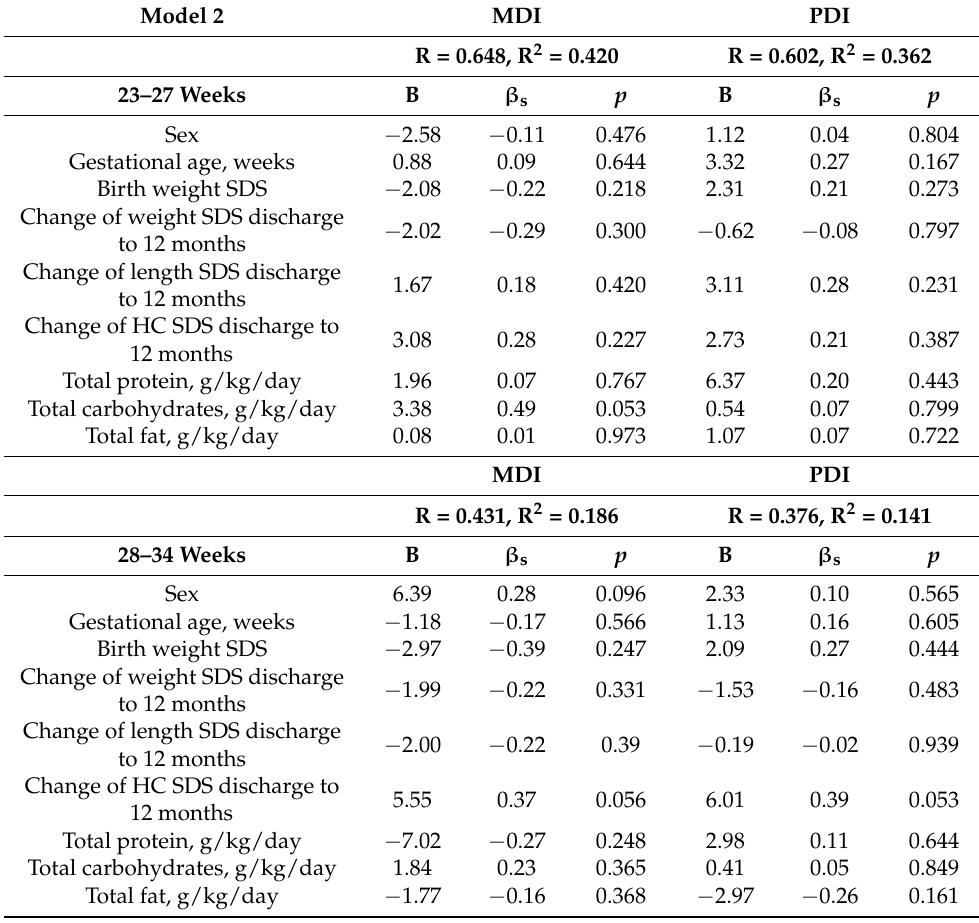
Table 5. Relationship between growth after discharge, average daily total nutrient intake during first 28 days, and neurodevelopment at 12 months of